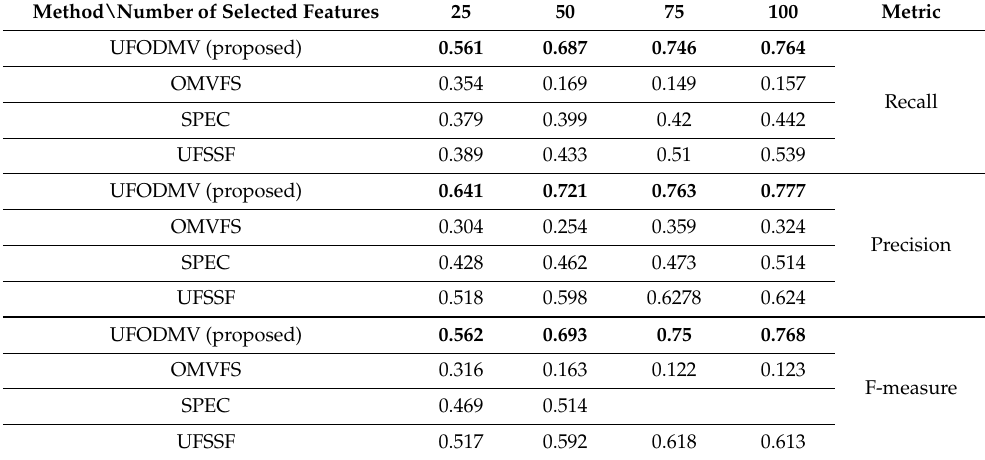
Table 7. Classification accuracy using Fox News dataset with naive